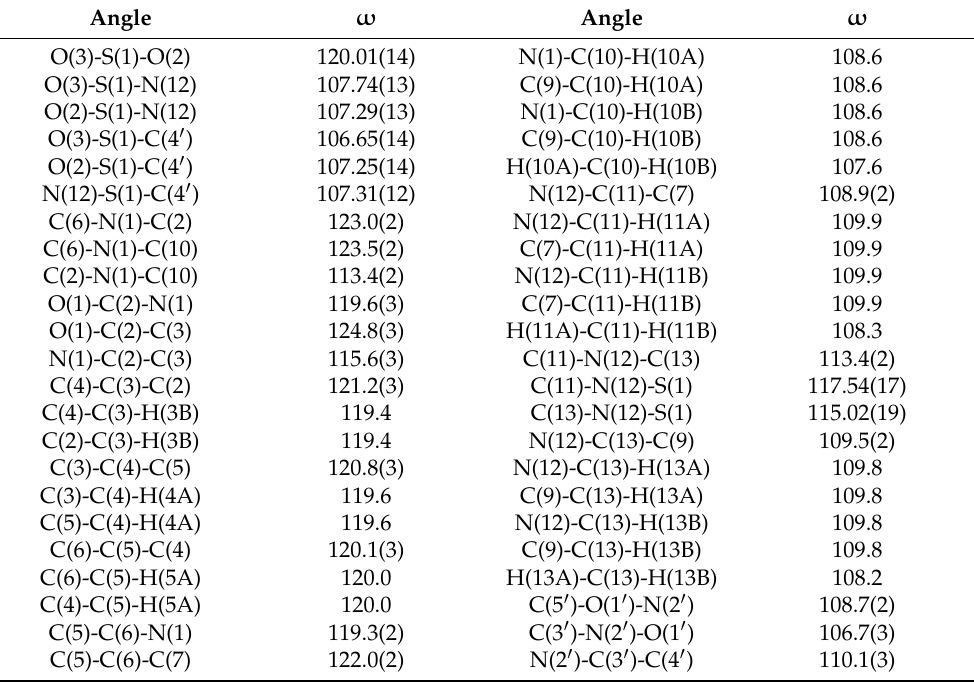
Table 2. Bond angles ( ω , deg.) in molecule 2